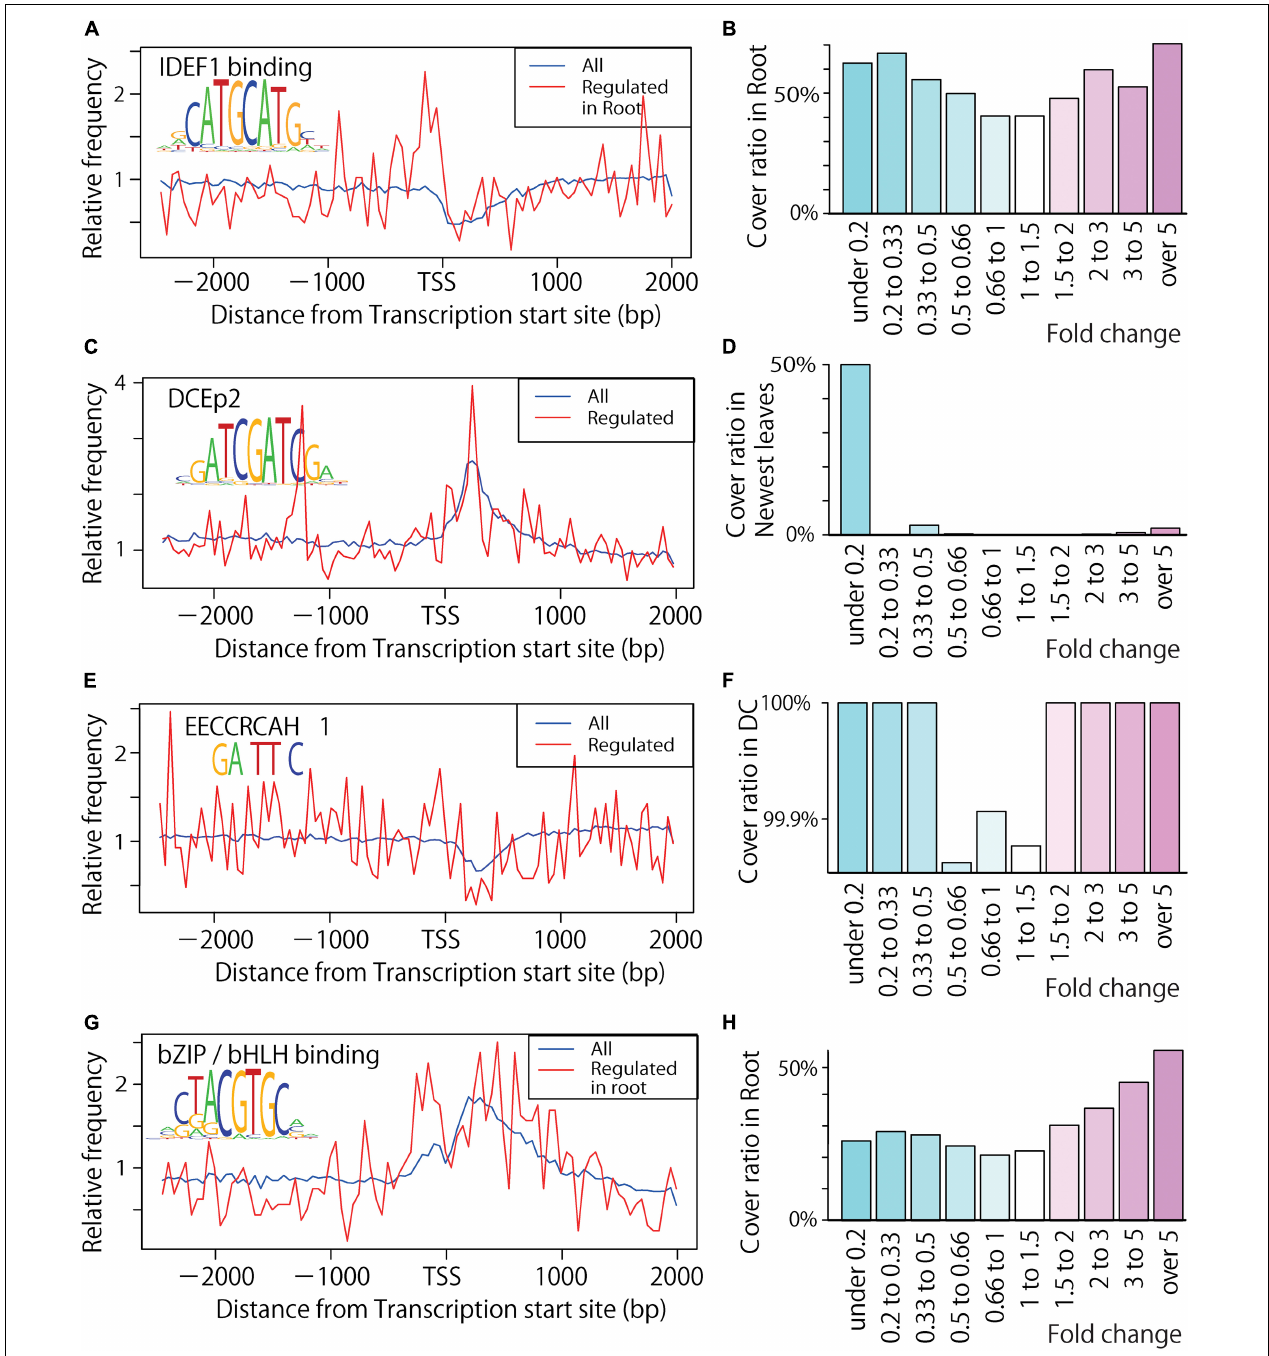
FIGURE 4 | Distribution of important CRE candidates in upstream sequences of Fe excess-responsive genes. (A) Distribution of the CATGCATG (IDEF1 binding) motif in all genes and in Fe excess-regulated genes of roots. Blue line shows all genes and red line shows the Fe excess-regulated genes. (B) Coverage ratio (percentage of genes including motif among the up- or down-regulated genes by Fe excess as fold changes described under graph) of the CATGCATG motif in the –500 bp to +150 bp area relative to the transcription start site (TSS) in Fe excess-treated rice roots. (C) Distribution of the ATCGATCG (DCEp2) motif in Fe excess-treated newest leaves. (D) Coverage ratio of the ATCGATCG motif in Fe excess-treated rice newest leaves. (E) Distribution of the GANTTNC motif (EECCRCAH1) in Fe excess-treated DC. (F) Coverage ratio of the GANTTNC motif (EECCRCAH1) in Fe excess-treated rice DC. (G) Distribution of CTACGTGC (bZIP/bHLH binding) motif in Fe excess-treated root. (H) Coverage ratio of the CTACGTGC (bZIP/bHLH binding) motif in Fe excess-treated rice roots. Graphs (A,C,E,G) show relative frequency compared to the percentage frequency in each 50 bp window within –3,000 to +2,000 bp of the TSS. Graphs (B,D,F,H) show coverage ratio of the motifs in the -500 bp to +150 bp area relative to the TSS in Fe excess-treated tissues. Numbers below the graphs (B,D,F,H) indicate gene expression ratios in Fe excess-treated rice relative to non-treated rice. DC means discrimination center or junction nodes between root and shoot.